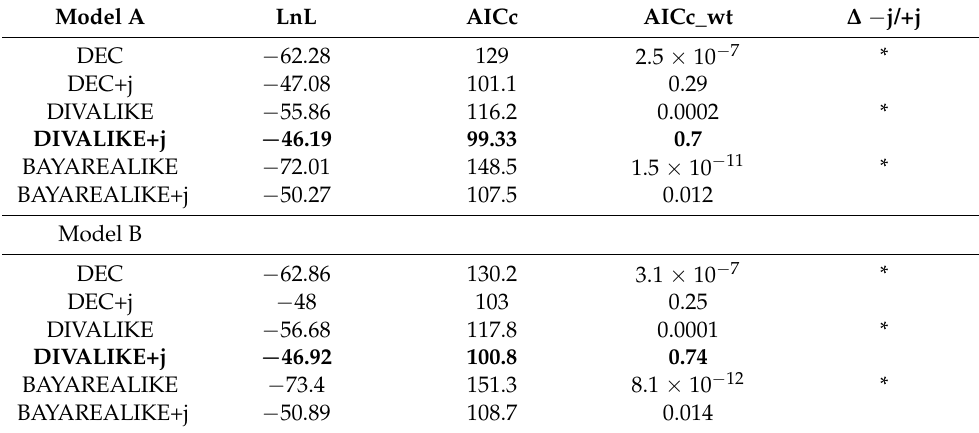
Figure 4. RASP ancestral area reconstruction of two alternative biogeographic models on a COI + 28S population-level phylogeny of Herennia . Model A assumes long-distance dispersal via ballooning as the main method of dispersal in coin spiders, while model B predicts that coin spiders mainly disperse over land with small-step, gradual expansion. Encircled letters signify the likeliest ancestral area in that node, with a combination of several letters indicating an inferred distribution in all those areas. Green area marks the major conflicts in ancestral area reconstruction between the two models. Table 1. RASP model scores for models A and B. Best supported RASP model is shown in bold. An asterisk (*) in the last column indicates that the model variant allowing jump dispersal (+j) was a significantly better fit for the data than the variant without